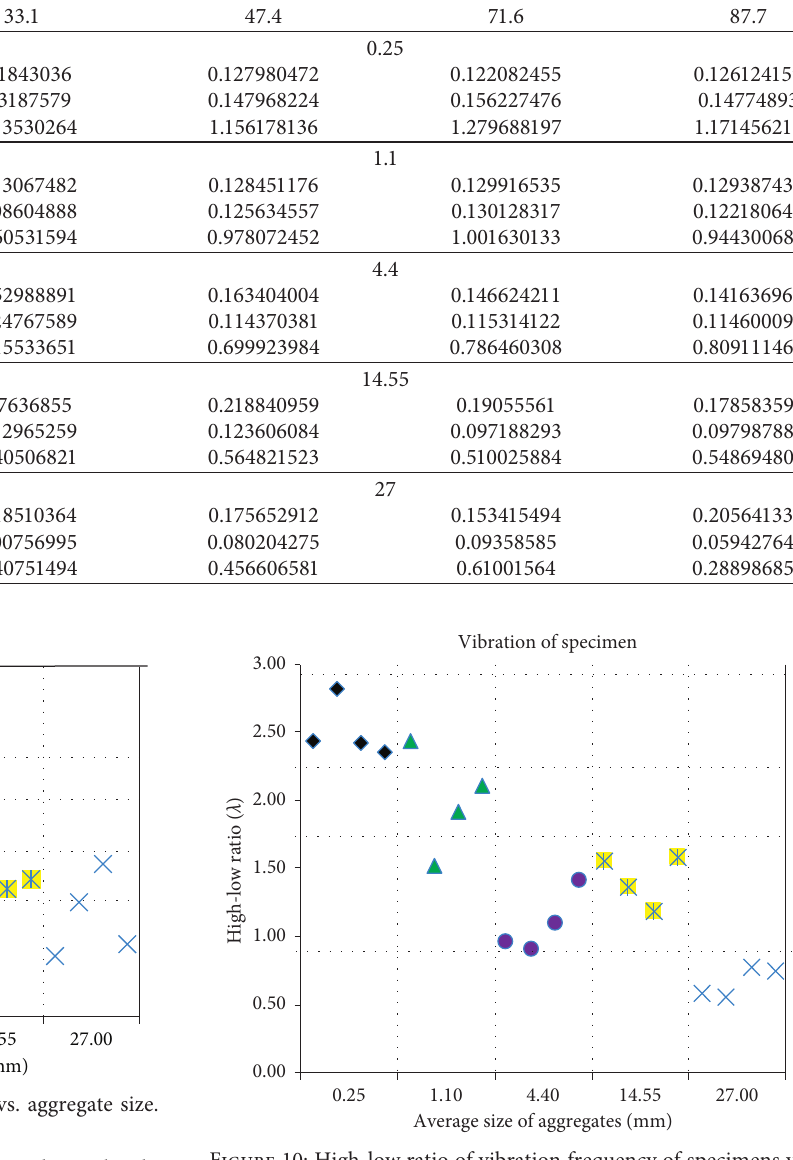
Figure 10: High-low ratio of vibration frequency of specimens vs. aggregate